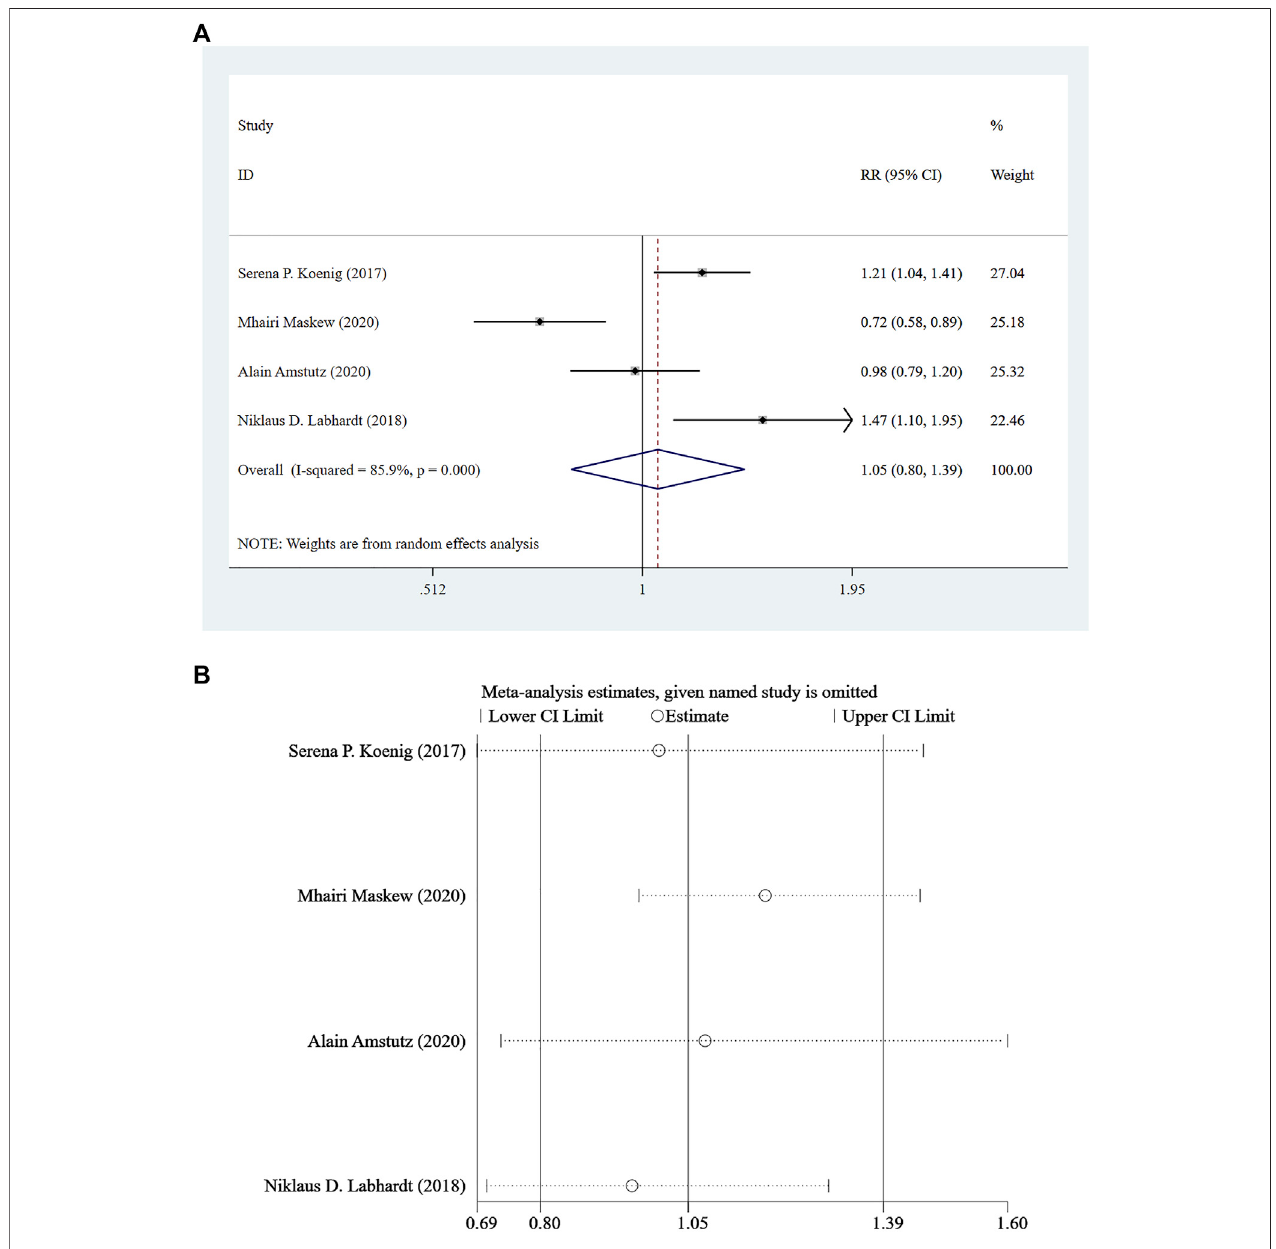
FIGURE 3| (A) Forest plot for Meta-analysis of statistical chart ofviral load < 100 copies/mL at 12 months after treatment. (B) Sensitivity analysisof statistical chart of viral load < 100 copies/mL at 12 months after treatment (After removing the literatures one by one, the circles of each study were within the two edges, indicating that the conclusions of this meta-analysis were stable and